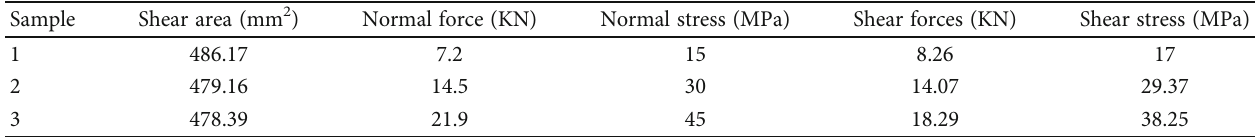
Figure 9: Typical failure modes of shale samples in mechanical experiments. Table 4: Direct shear testing results.